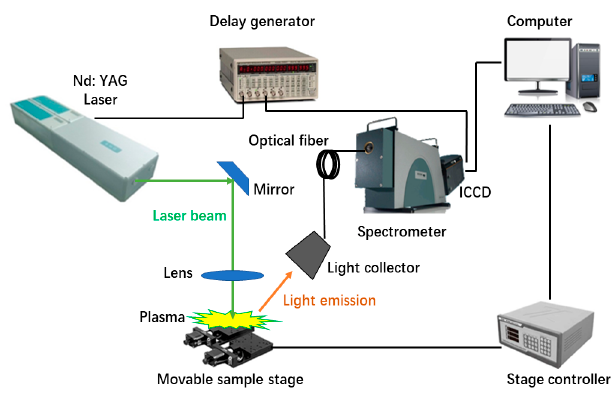
Figure 1. The structural diagram of the LIBS system.